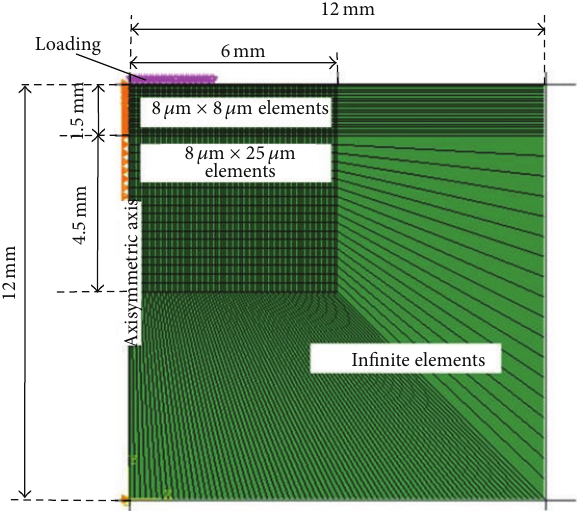
Figure 1: The finite element model for thick flat